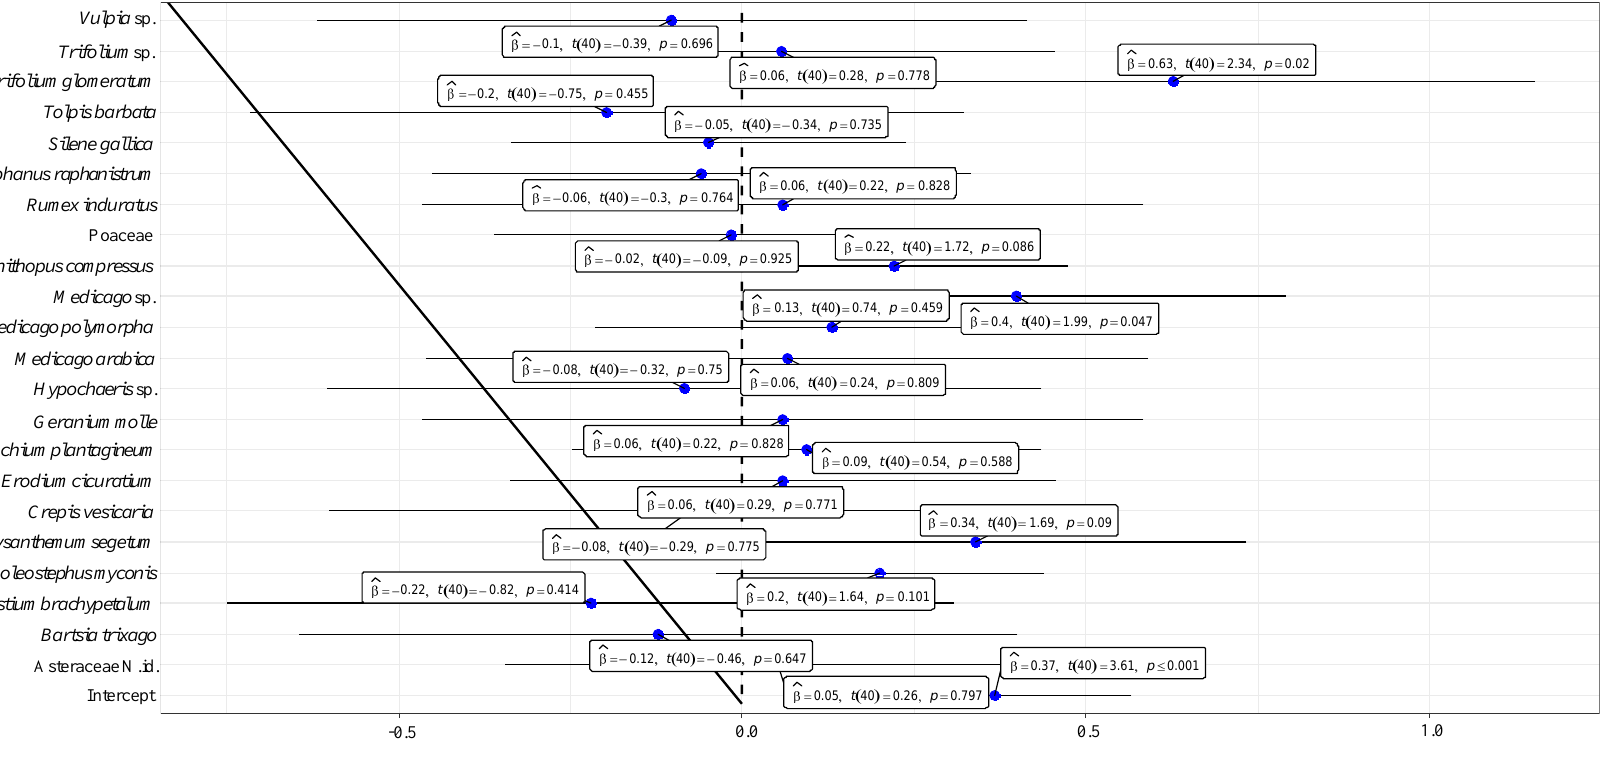
Figure 3. Estimated regression coefficients (β), t values (degrees of freedom), and p -values (within boxes) for the weighted number of nymphs by the plant cover as a function of each taxa identity in an abandoned olive orchard on 26 April 2017, obtained with linear mixed models. Blue points represent β and bars the confidence intervals. N. id. after taxa means not identified specimens belonging to that group. The dotted vertical line indicates the 0 value for the standardized regression coefficients. AIC: Akaike information criterion. BIC: Bayesian information criterion.